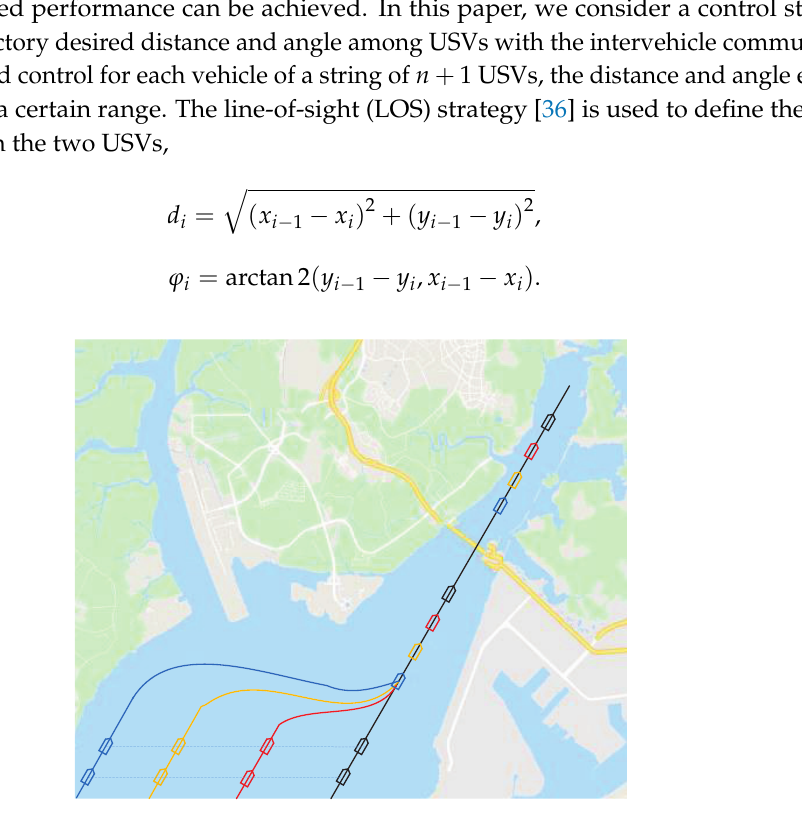
Figure 3. Platoon formation control graphic description in a real-time